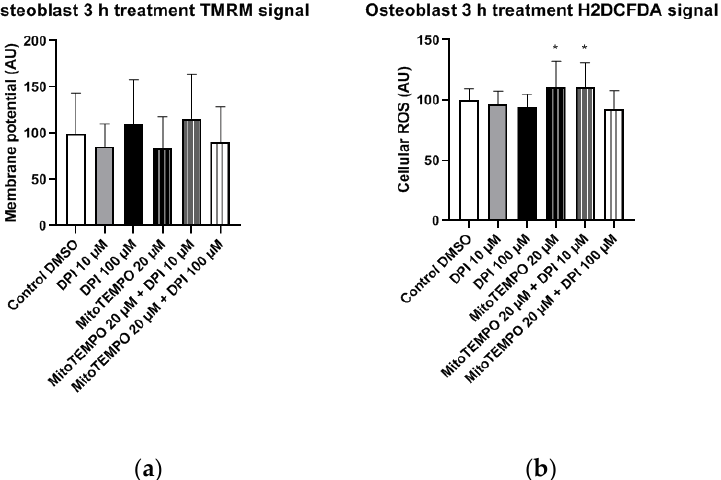
Figure 10. Mitochondrial membrane potential and cellular ROS levels 3 h after the treatment of osteogenic-induced hBMSCs (osteoblast-like cells) with diphenyleneiodonium chloride (DPI) and MitoTEMPO. ( a ) Changes in the mitochondrial membrane potential. ( b ) Changes of the cellular ROS levels. Data is represented as means + SD (error bars) ( n = 24; each point was obtained by analyzing 2–4 single cells; cells used in these experiments were obtained from the differentiating passage 2 hBMSCs. * p < 0.05; one-way ANOVA followed by multiple comparison post-hoc Fisher’s LSD test.